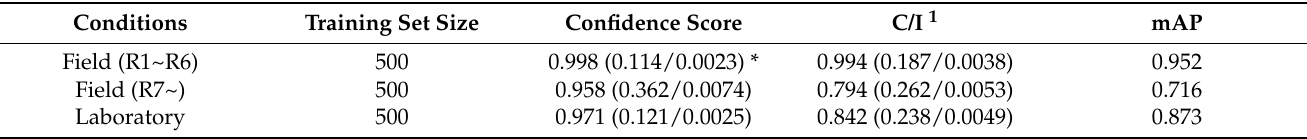
Table 1. Classification performance of each